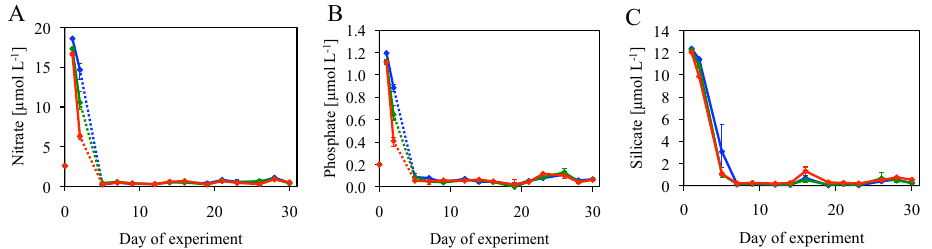
Fig. 1. Temporal development of (A) nitrate and (B) silicate in the mesocosms at low (blue), intermediate (green) and high (red) temperature. Vertical lines denote range of replicates within each temperature treatment.